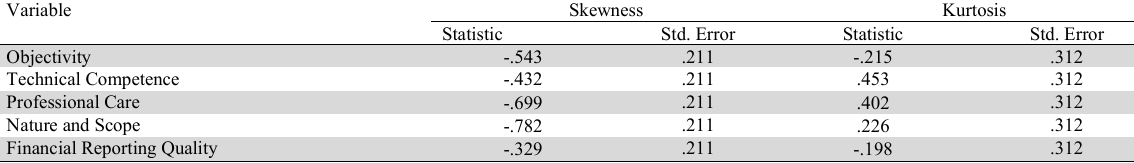
Result of Skewness and Kurtosis Tests Variable Skewness Kurtosis